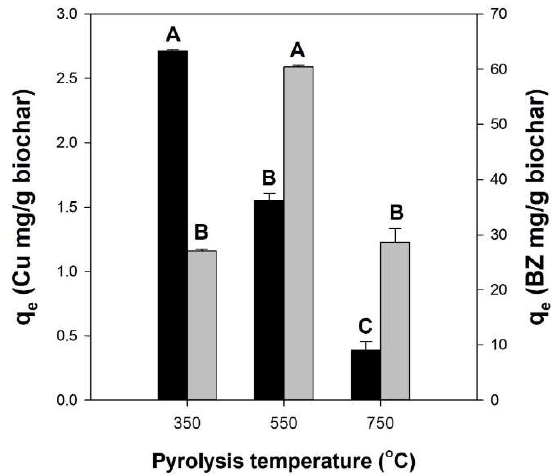
Figure 1. Adsorption capacities of pitch pine-based biochars produced at different pyrolytic temperatures (350, 550, and 750 °C) for Cu 2+ (black bars) and benzene (gray bars) at equilibrium. One-way ANOVA with Tukey’s test ( p < 0.05); A, B, and C indicate group classified from Tukey’s test. The same letter means that there is no significant difference between the data.